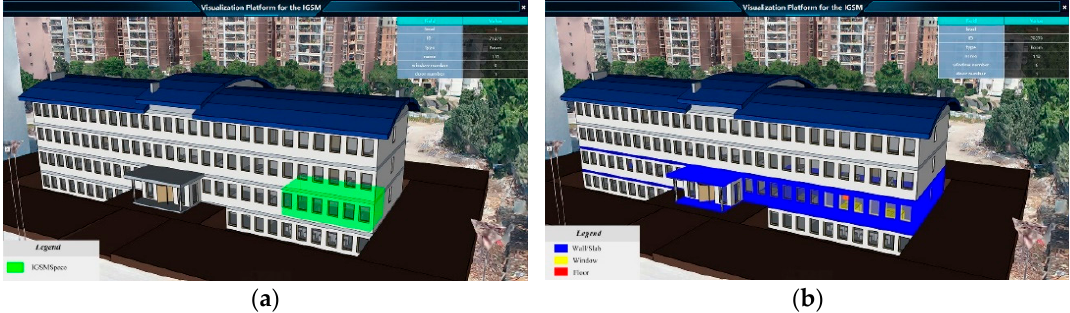
Figure 16. Result of indoor spatial query in the virtual globe (sample data from Table 2. Office Building). ( a ) Effect of showing the selected IGSMSpace. ( b ) Effect of showing building elements composed of the selected IGSMSpace.